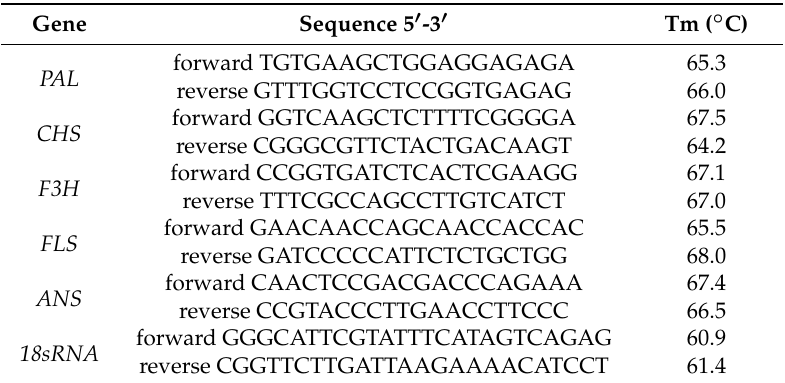
Table 1. List of primers used for the real-time PCR